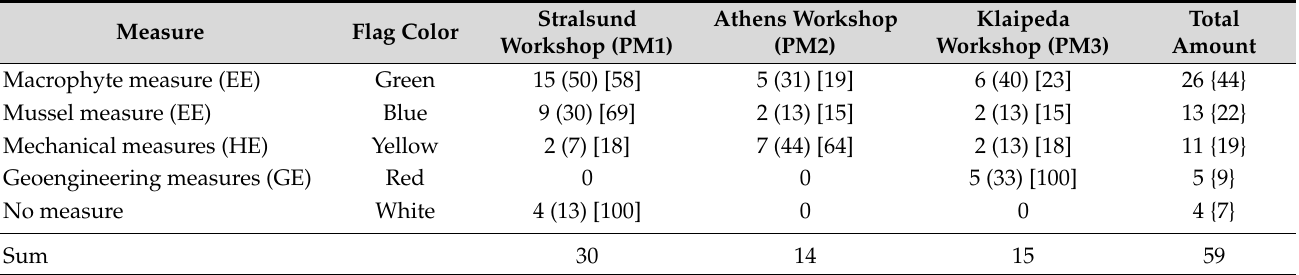
Table 4. Amount of flags pinned for potential installation sites for different internal nutrient removal measures. The round brackets show the percentages per workshop, the square brackets show the percentage distribution across all workshops, and the curved brackets the total share of all measures